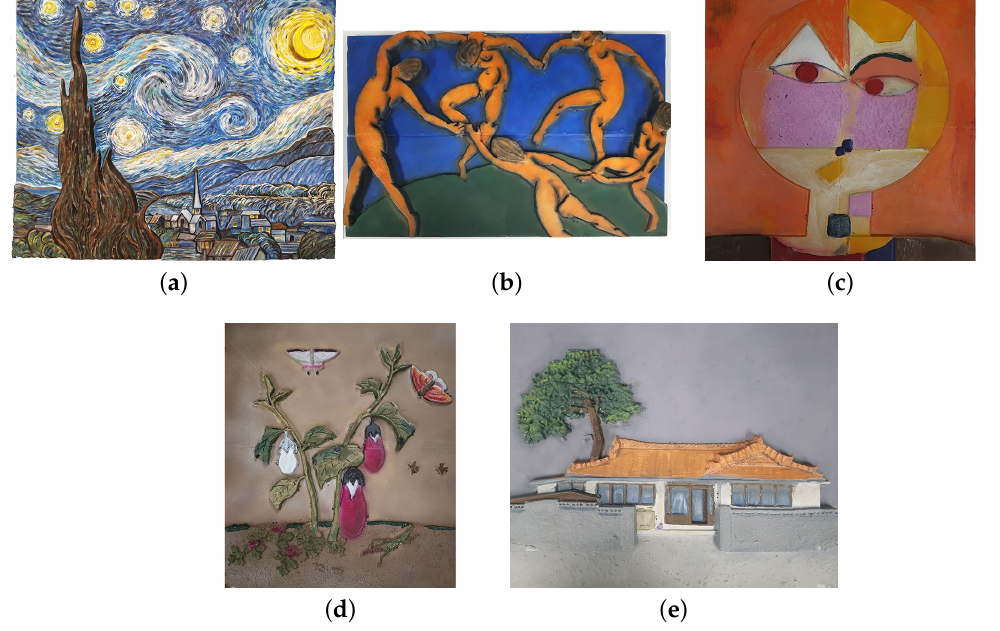
Figure 3. Usability study IMG artwork models. ( a ) The Starry Night—Vincent van Gogh; ( b ) Dance—Henri Matisse; ( c ) Senecio—Paul Klee; ( d ) Flowers and Insects—Sin Saimdang; ( e ) Hyunsook’s House—Kim